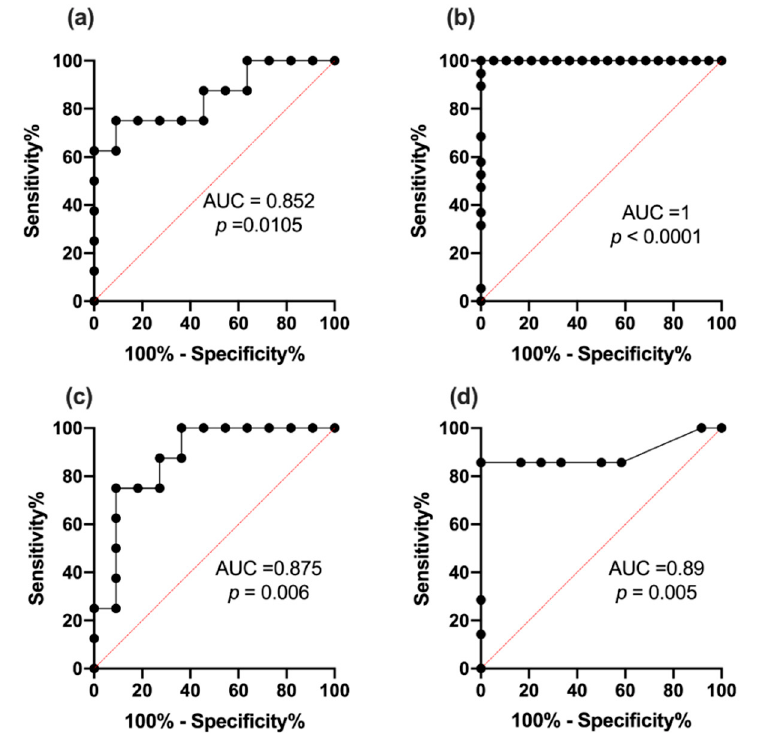
Figure 5. ( a ) ROC curve for miR-342-3p in type 1 diabetes and healthy controls; ( b ) ROC curve of HbA 1c indicating downregulated miR-342-3p expression; ( c ) ROC curve for miR-342-5p in type 1 diabetes and healthy controls; ( d ) ROC curve of HbA 1c indicating downregulated miR-342-5p